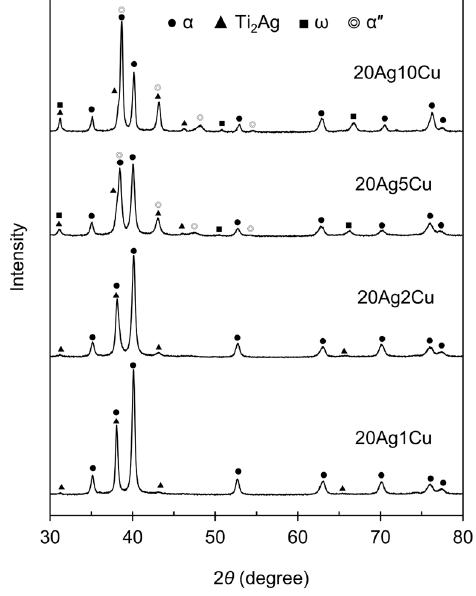
Figure 2. X-ray diffraction patterns of the Ti-Ag-Cu alloys.